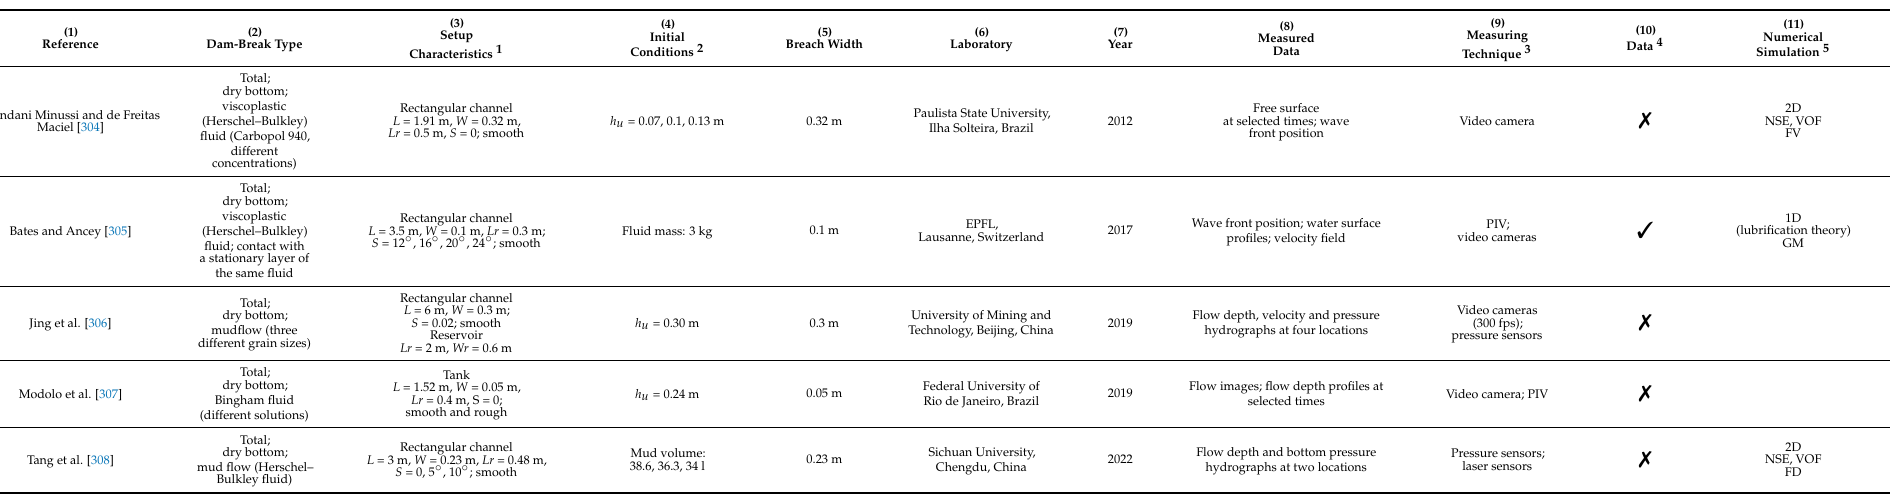
Table 1. Basic experimental investigations of fundamental dam-break wave physical characteristics.